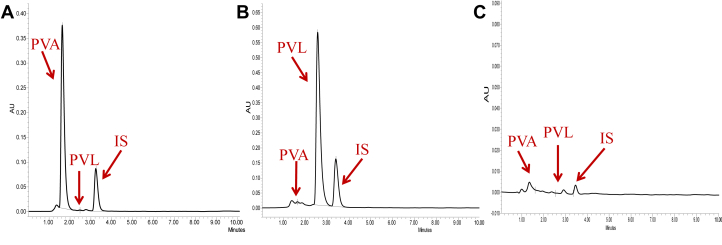
HPLC chromatograms of (A) PVA spiked into Dulbecco's modified eagle medium (pH 7.4) with internal standard (IS = griseofulvin), (B) PVL spiked into Dulbecco's modified eagle medium (pH 7.4) with internal standard (IS = griseofulvin), (C) blank culture medium. PVA, pravastatin hydroxy acid; PVL, pravastatin lactone; IS, internal standard.